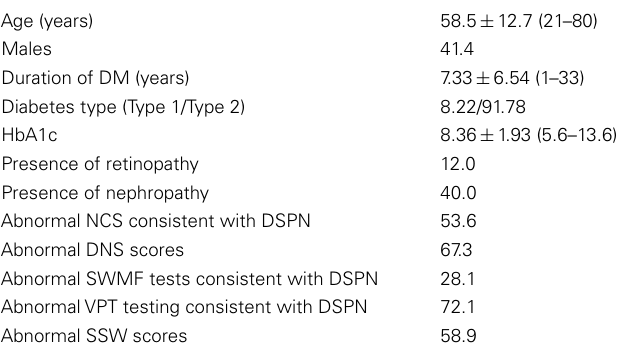
Table 1 | Patient